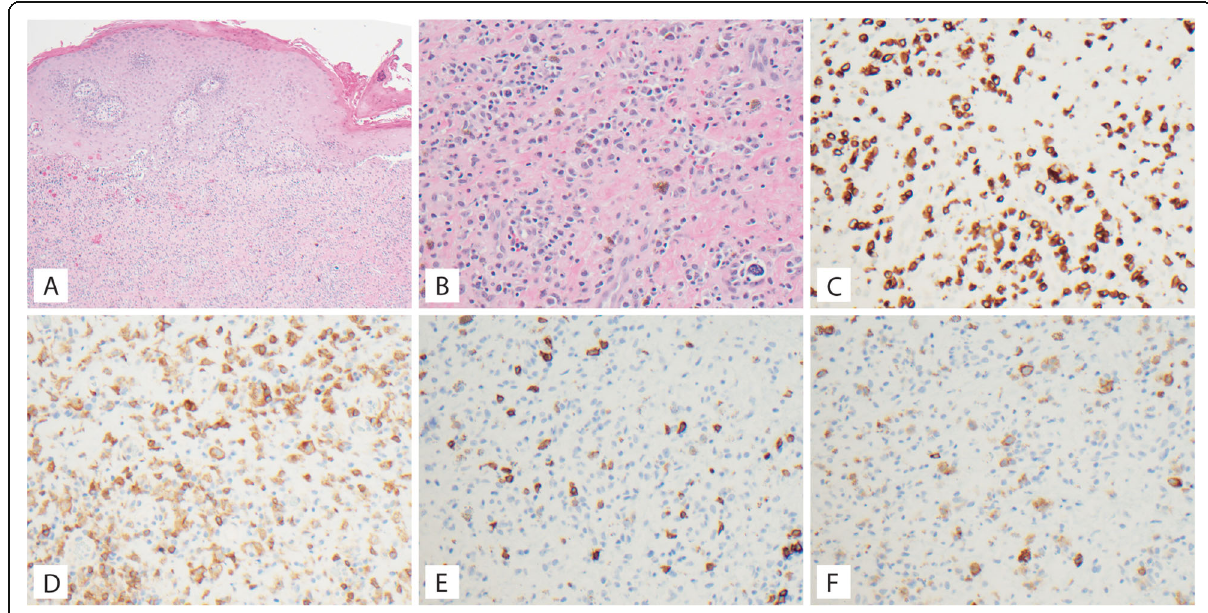
Fig. 7 Microscopic images of Case 2 biopsy of left upper back biopsy. a Skin with a dermal and epidermotropic infiltrate of atypical lymphocytes with irregularly contoured nuclei; H&E 40X. b Higher power shows that a subset of cells is large in size; H&E 200X. c CD3 immunostain; 200X. d CD4 immunostain; 200X. e CD8 immunostain; 200X. f CD30 immunostain;